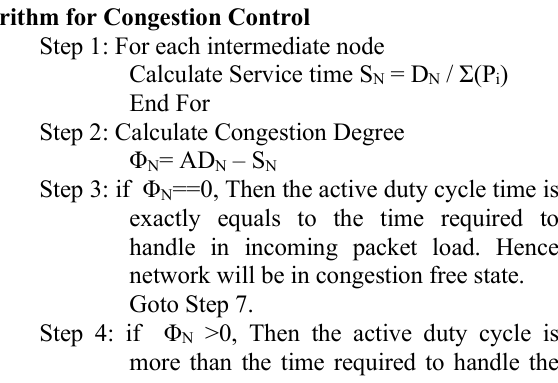
Figure 4. The Network